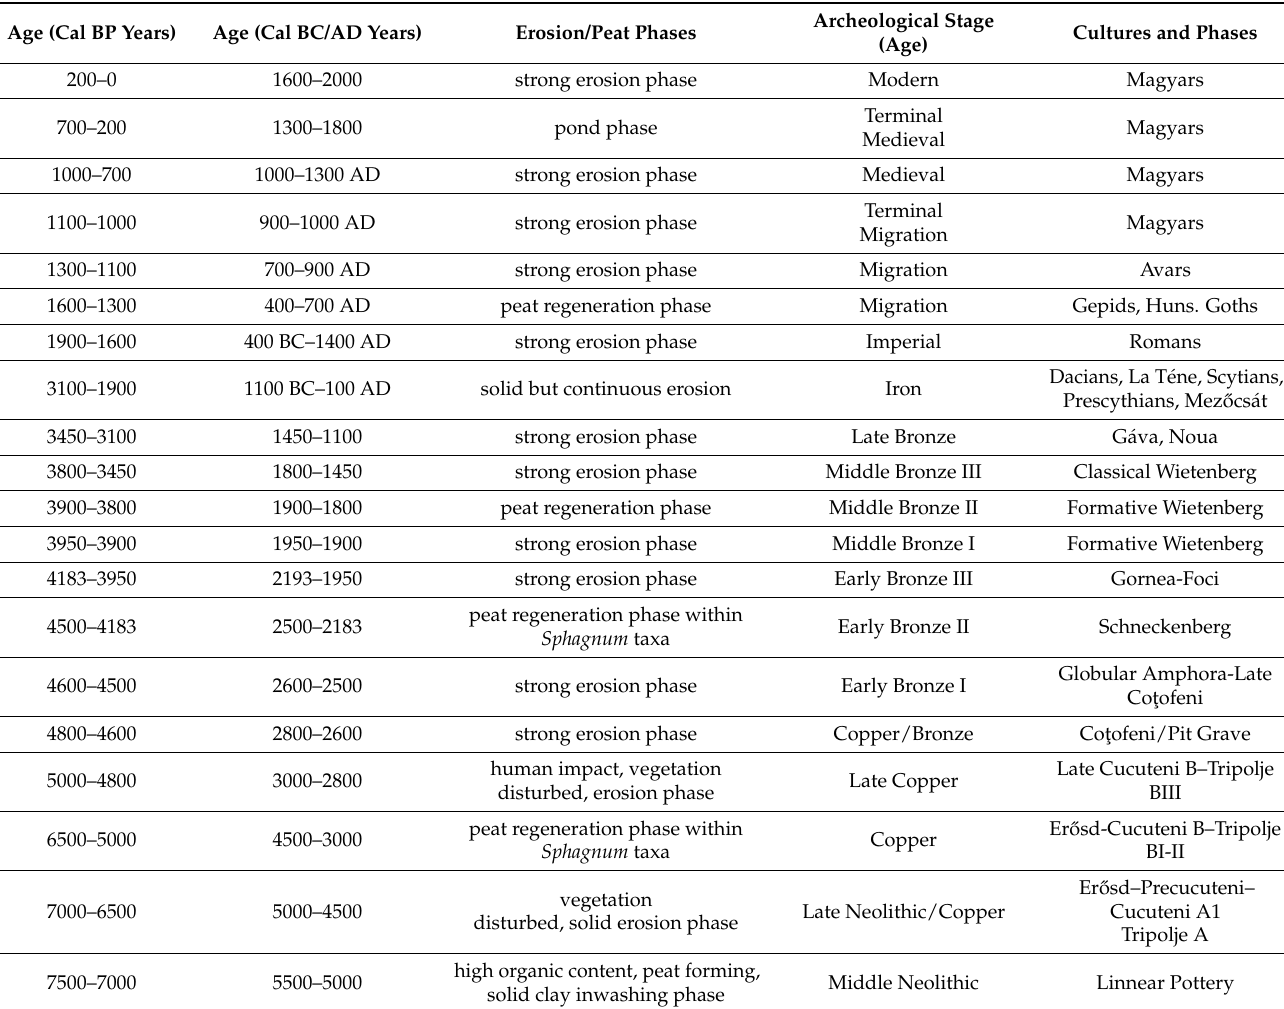
Table 6. Age, erosion and peat regeneration phases within archaeological and cultural data-historical data around the analysed catchment basin archaeological remains in the Homor ó d Hills based on